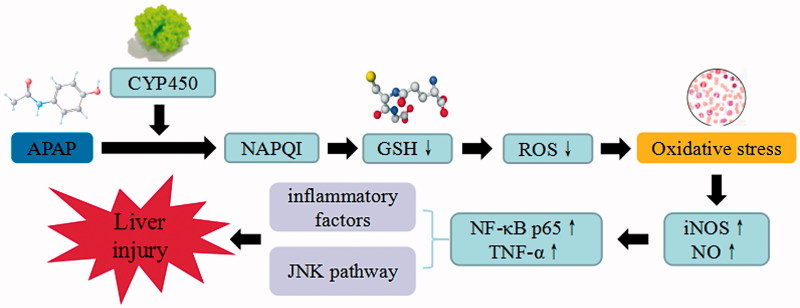
APAP-induced liver injury. APAP trigger the continuous development of hepatocyte injury by inducing cell stress via inflammation, oxidative stress, and JNK pathway, resulting in hepatic necrosis, apoptosis, hepatic fibrosis, and liver injury. CYP450: cytochrome P450; NAPQI: N-acetyl-p-benzoquinonimine; GSH: glutathione; ROS: reactive oxygen species; iNOS: inducible nitric oxide synthase; NF-κB: nuclear factor κB; TNF-α: tumor necrosis factor α.